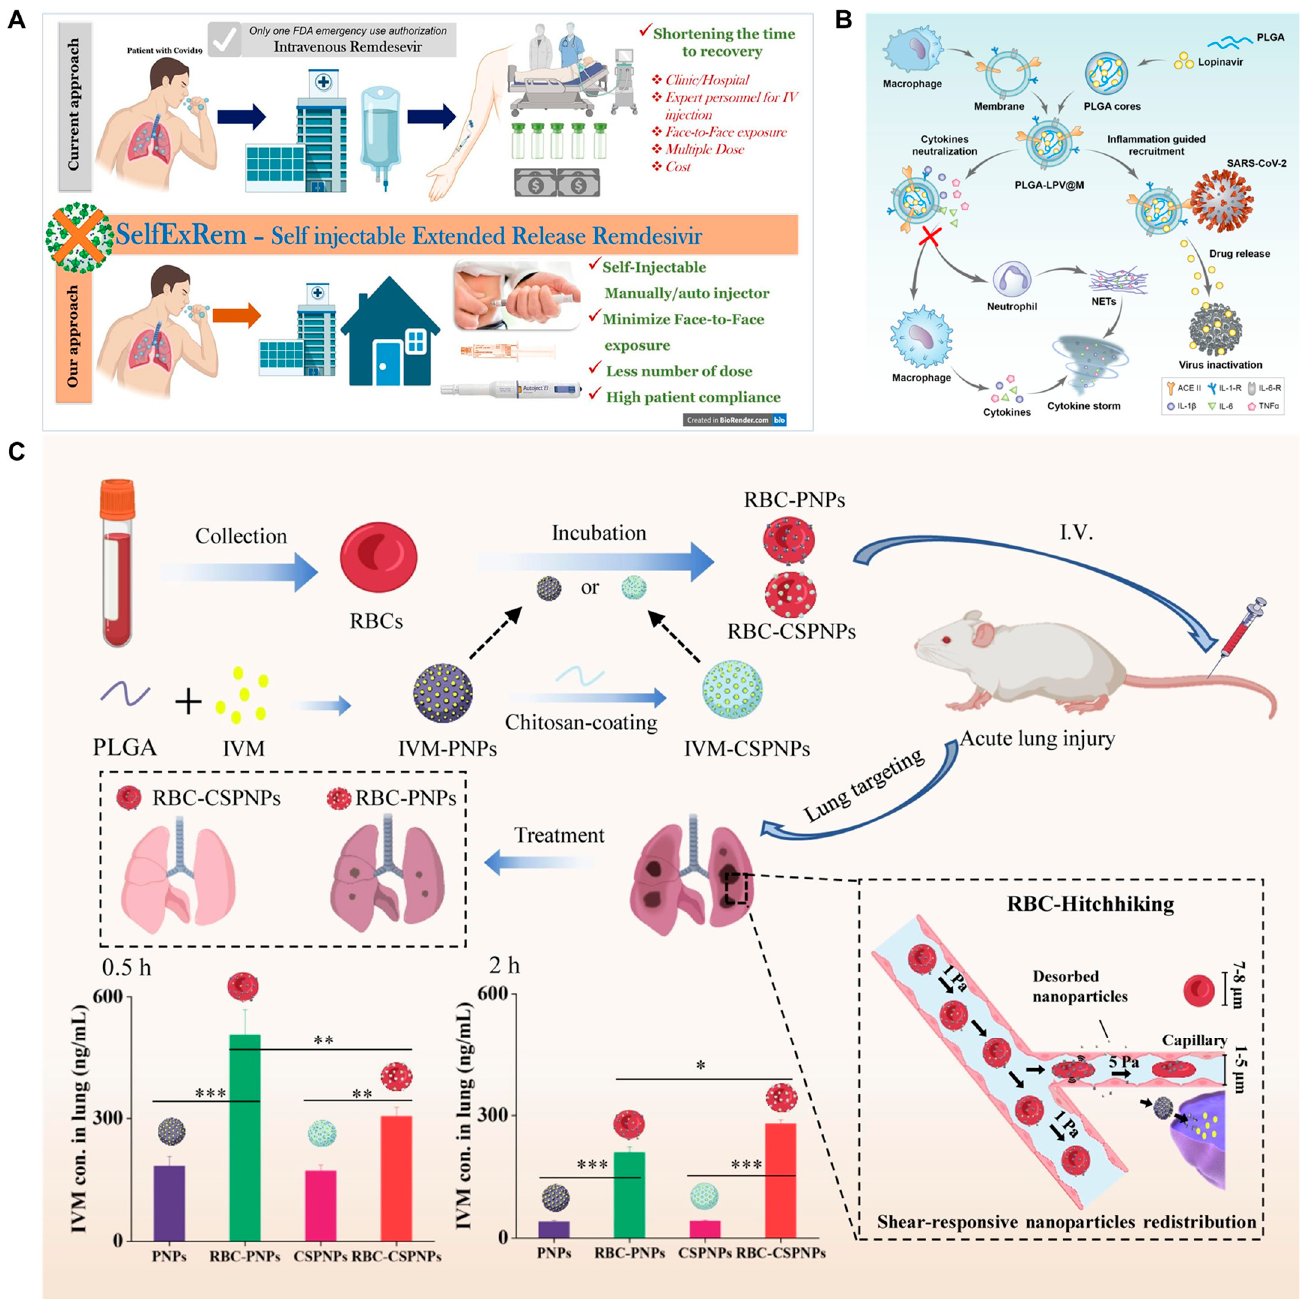
Figure 6. ( A ) Schematic representation of SelfExRem. Reproduced with permission from [180] ( B ) Schematic illustration of macrophage biomimetic nanocarriers based drug delivery system (PLGA- LPV@M) for anti-inflammation and targeted antiviral treatment in COVID-19. Reproduced with permission from [182]. ( C ) Diagram of the red blood cell (RBC)-hitchhiking strategy. Reproduced with permission from [184]. * P < 0.05, ** P <0.01, *** P < 0.001.